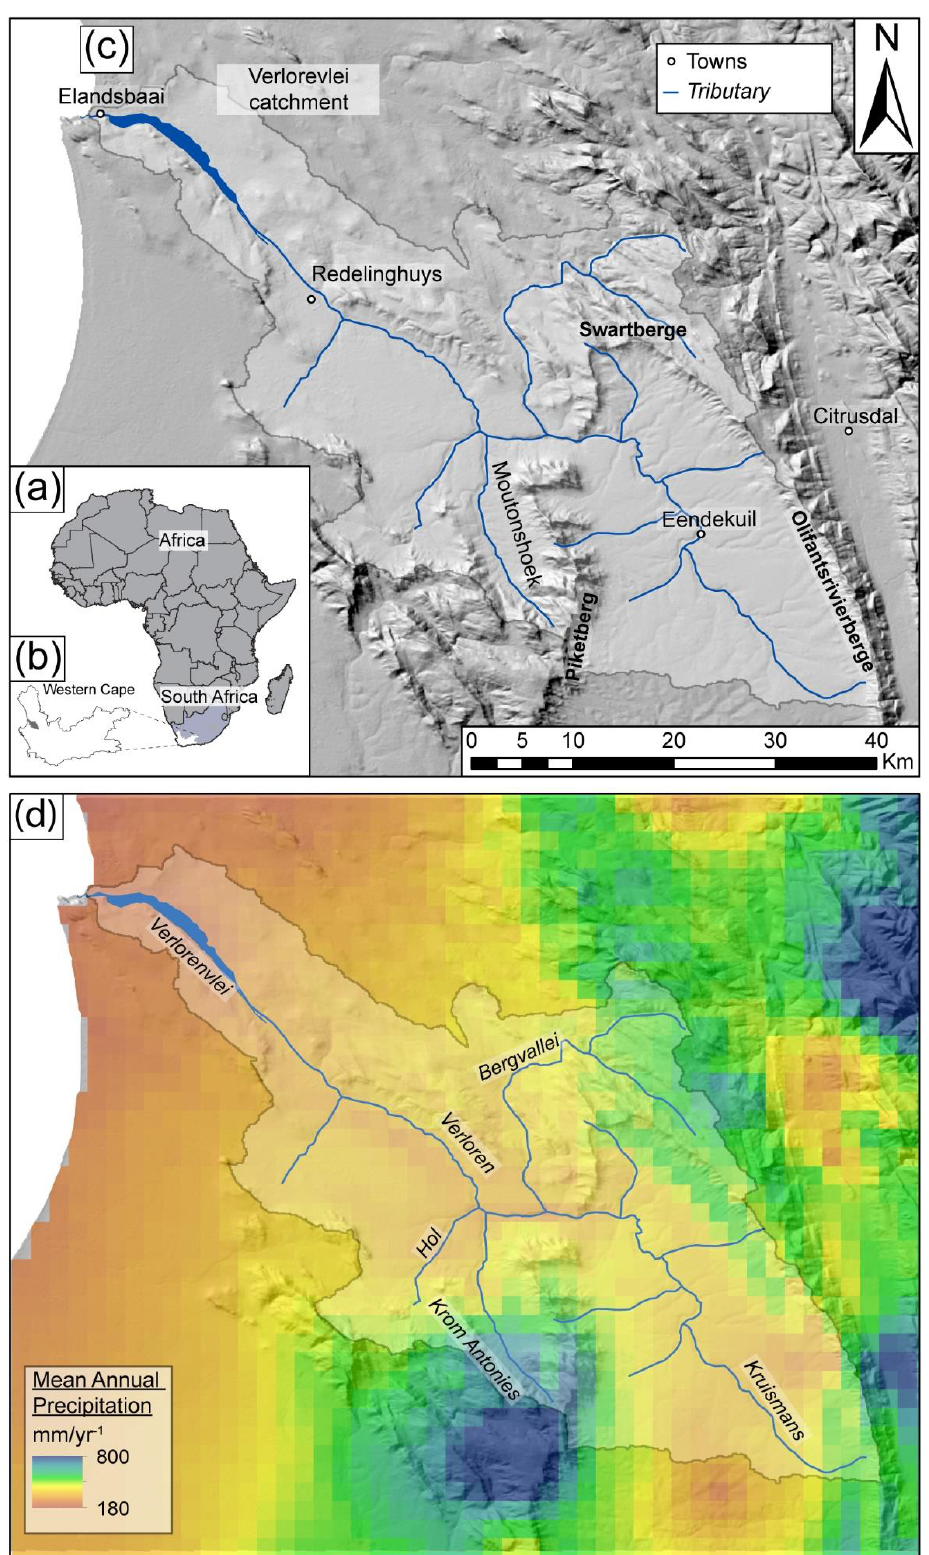
Figure 1. ( a ) Location of South Africa within Africa; ( b ) location of Western Cape (WC) within South Africa showing the study catchment; ( c ) Verlorenvlei catchment with the location of the two main mountain ranges as well as the Moutonshoek valley; and ( d ) feeding tributaries within the catchment overlain on the distribution of mean annual precipitation derived from [31].